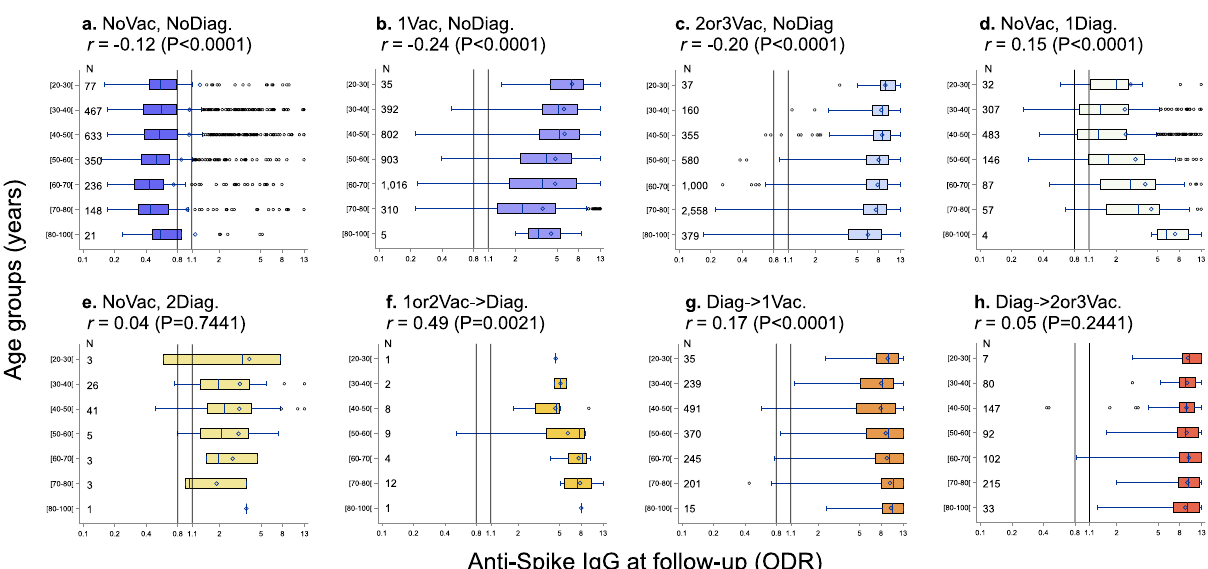
Figure 2. Distribution (boxplot) of anti-spike IgG (ODR) according to age groups by follow-up profiles ( a–h ). The dashed lines show the threshold values for a positive (≥ 1.1), indeterminate [0.8–1.1[ or negative (< 0.8) test result. Spearman correlation coefficients between age and log-IgG titer are